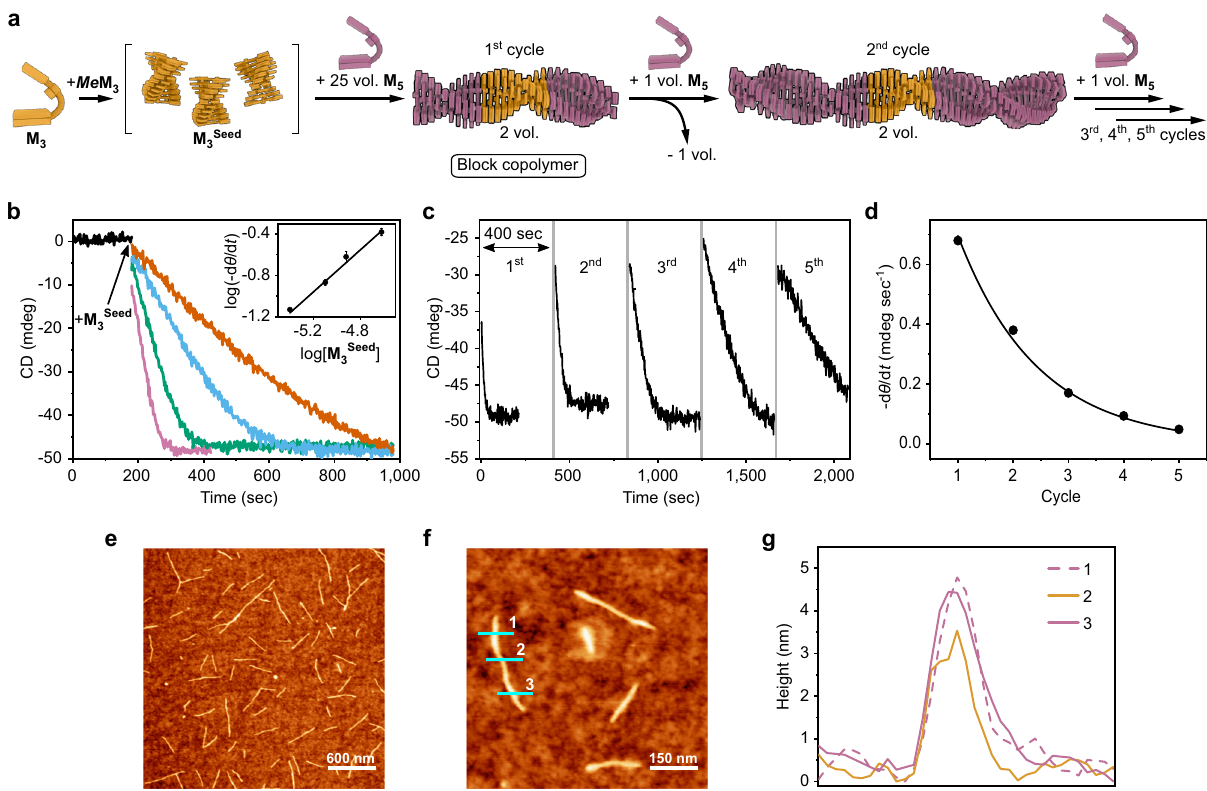
Fig. 5 Supramolecular block copolymers. a Schematic illustration of the synthesis of block copolymers by seeded LSP in a multicycle kinetic experiment. b Time course of supramolecular polymerization of M 5 initiated by addition of different amounts of M 3 Seed : [ M 5 ]/[ M 3 Seed ] = 50:1 (pink curve), 100:1 (green curve), 150/1 (blue curve), 300:1 (orange curve) v/v. Inset shows log-log plot of the rate of polymerization as a function of M 3 Seed concentration. Error bars correspond to one standard deviation of a triplicate measurement. Solid line corresponds to linear fi t with slope 1.02 (correlation coef fi cient 0.987). c Time course of change of the CD signal at 260nm, while M 5 -M 3 -M 5 supramolecular block copolymer obtained using [ M 5 ]/[ M 3 Seed ] = 25:1 ratio (1st cycle), was diluted with M 5 over fi ve cycles. Polymerization continues upon each addition of M 5 but at increasingly slower rate. d Plot of initial slopes (sec − 1 ) as a function of the cycle number. Solid line corresponds to exponential fi t, demonstrating bisection of the slope during each cycle. e Representative AFM height image of M 5 -M 3 -M 5 supramolecular block copolymers obtained using [ M 5 ]/[ M 3 Seed ] = 3:1 ratio, spin-coated on silicon wafer. f , g AFM height image and cross-section analyses along the blue lines demonstrating the presence of thicker termini, corresponding to M 5 block, and thinner middle part, corresponding to M 3